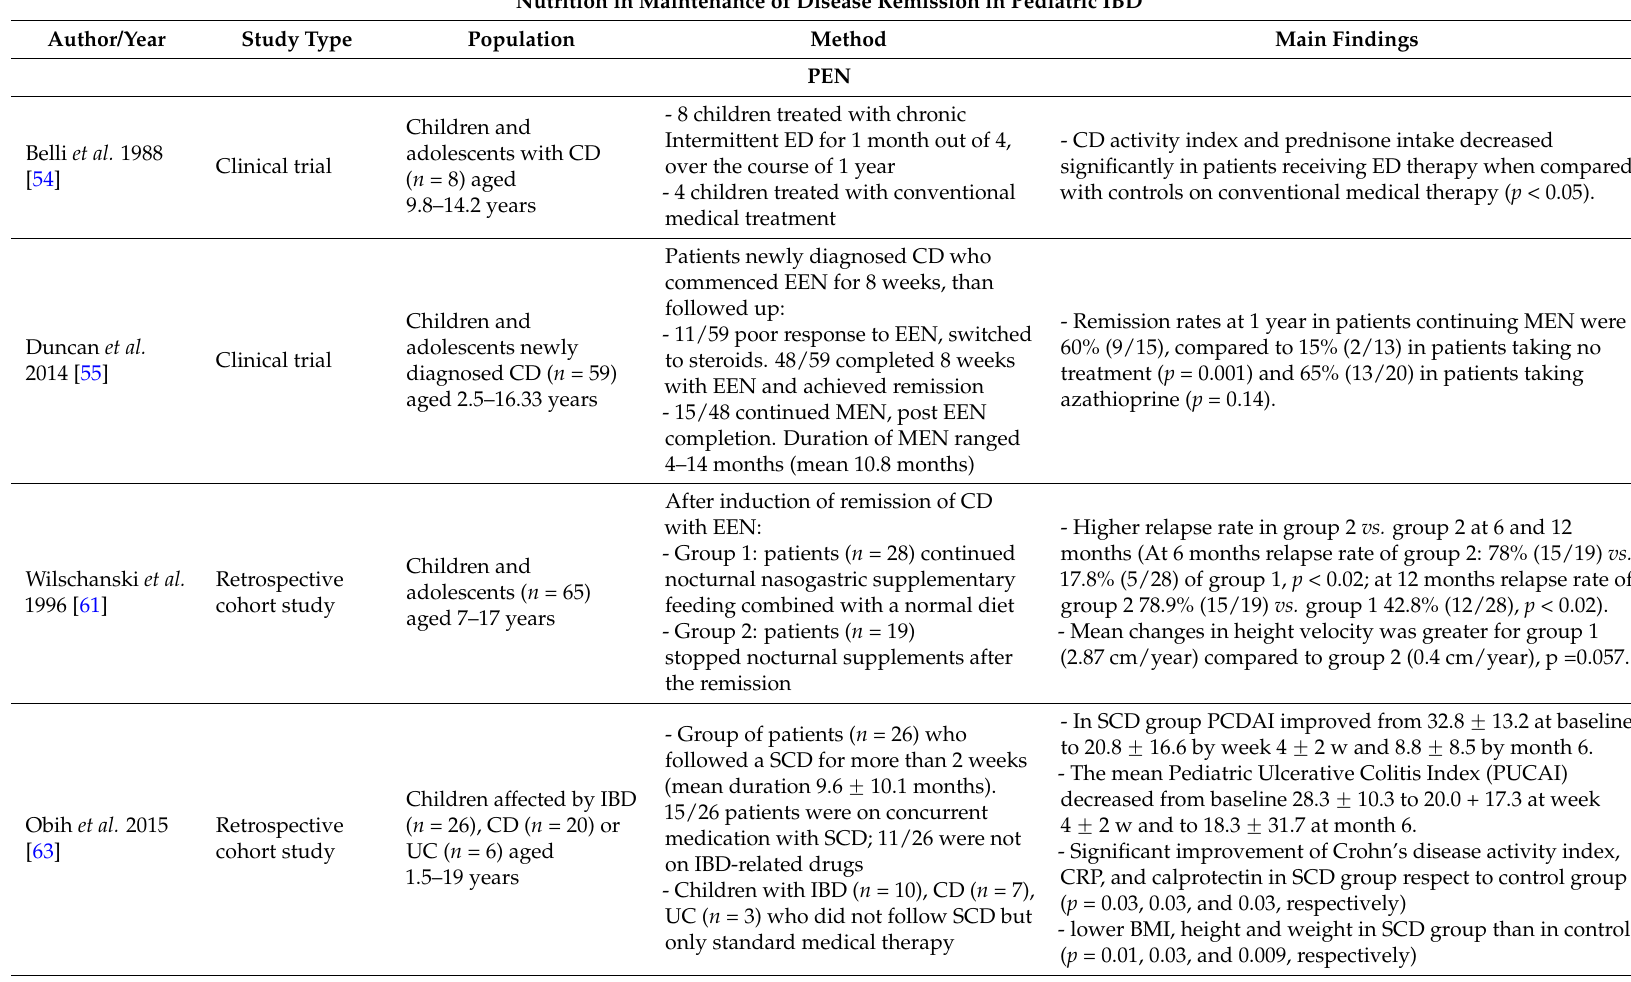
Table 6. Nutrition in maintenance of disease remission. ED = elemental diet, MEN = maintenance enteral nutrition, EEN = exclusive enteral nutrition, SCD =